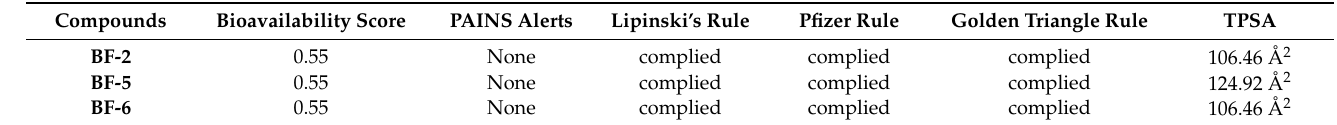
Table 7. Drug-likeness profile of Bromobenzofuran-oxadiazoles BF-2 , BF-5 and BF-6